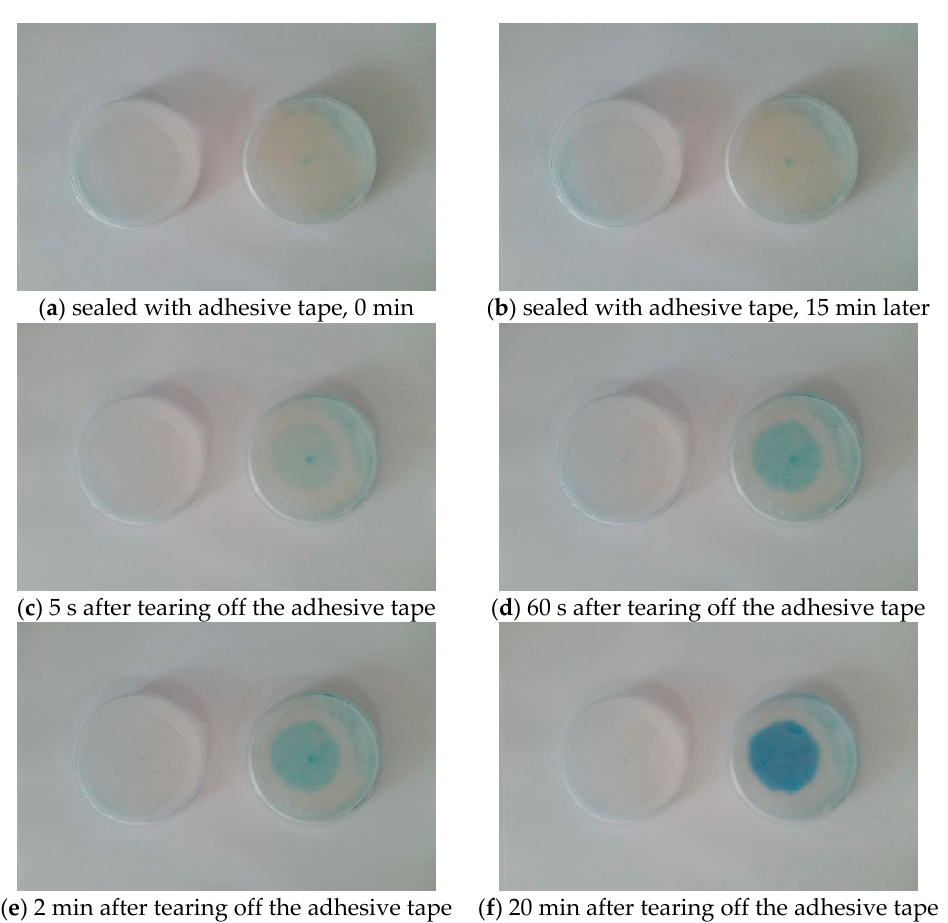
Figure 7. Color change of agar block. The bottom surface of the petri dish on the right was covered by the ramie fiber/starch nonwoven film whereas the left was not, the diameter of the petri dish was 9 cm.